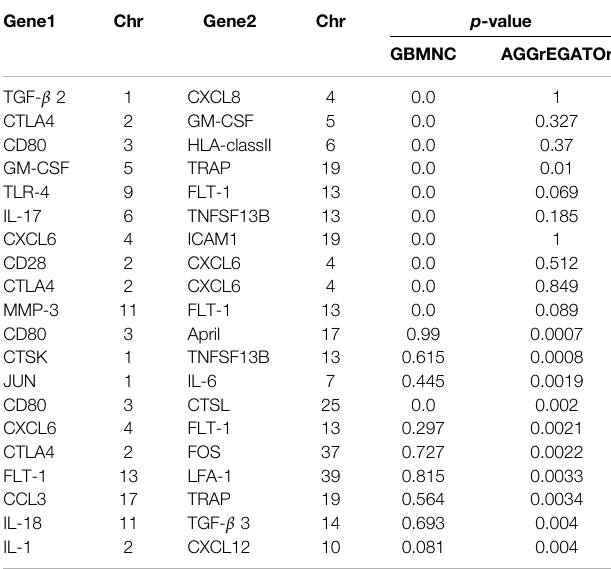
TABLE 6 | The calculated p -value for the 20 gene pairs using GBMNC and AGGrEGATOr. p -values in bold font indicate that they are signi fi cant. The “ Chr ” columnindicatesthechromosomenumberofthehumangenomewherethe gene is